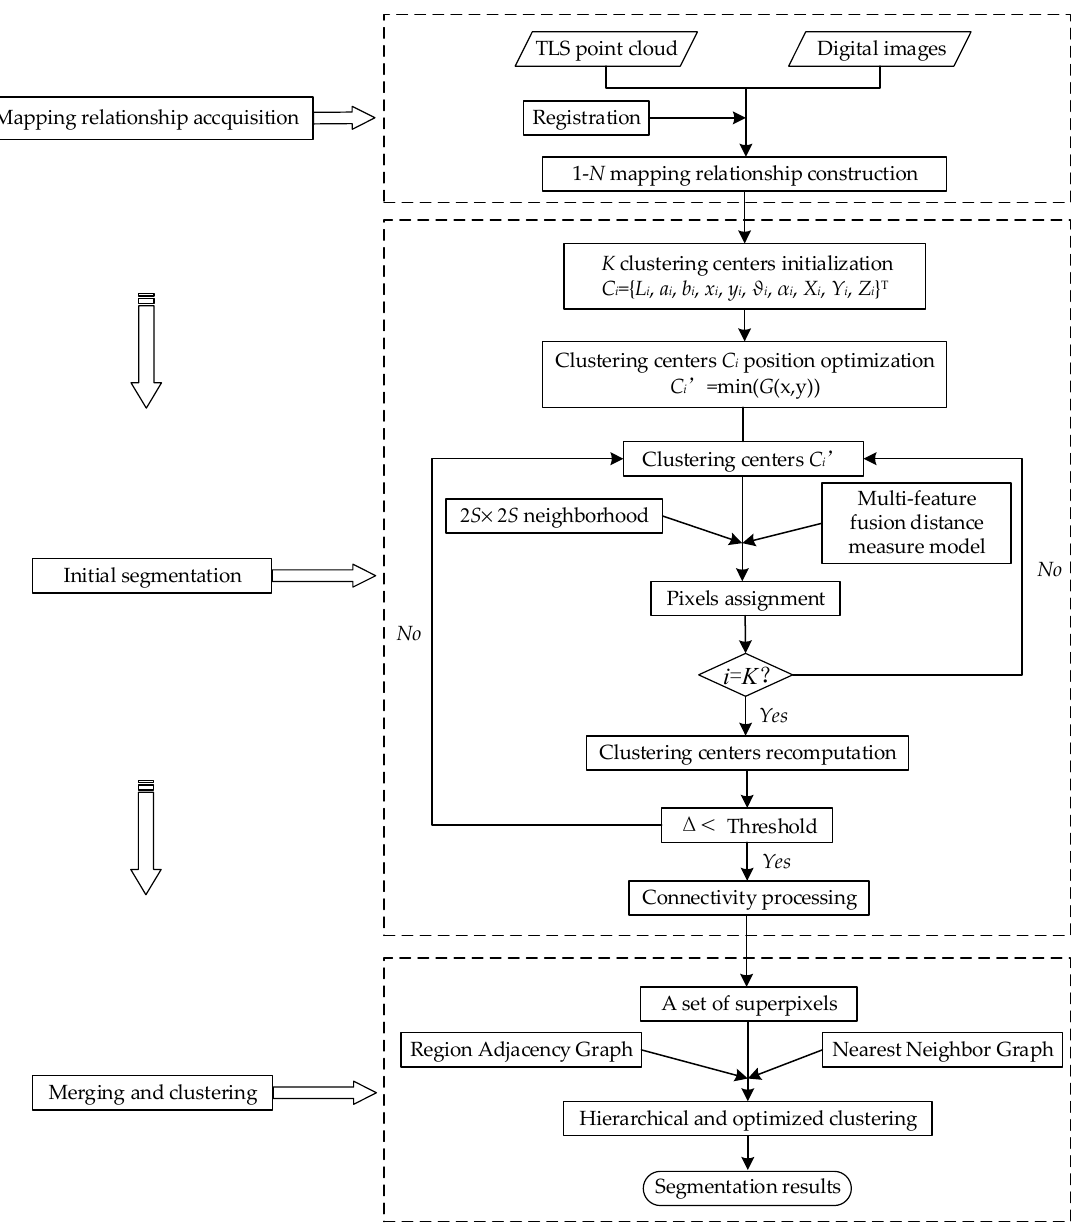
Figure 2. The flowchart of MFF-SLIC hybrid superpixel segmentation algorithm.